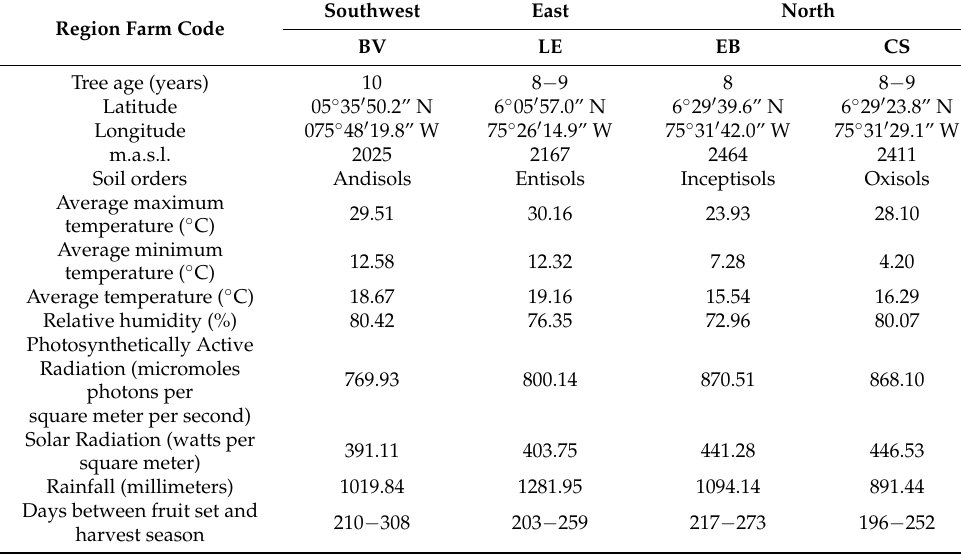
Table 1. Location and geographical information for the farms where avocado cv. ‘Hass’ fruits were